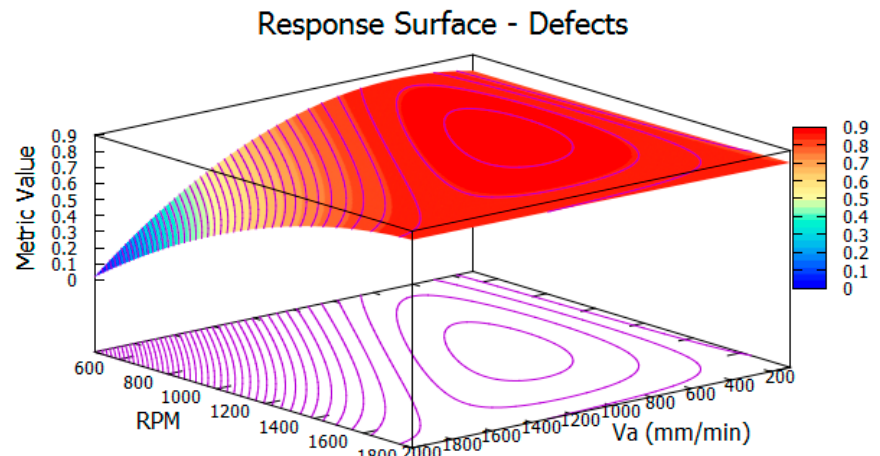
Figure 11. Predicted defects for the 15 cases.